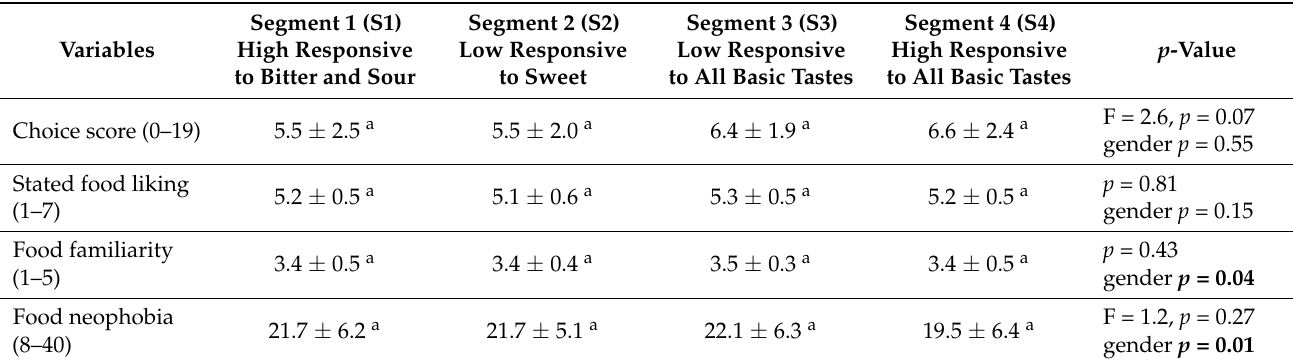
Table 3. Mean value for choice score, stated food liking, familiarity and neophobia according to the four taste responsiveness segments.